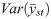

Var(y¯st) for haemoglobin in real data.